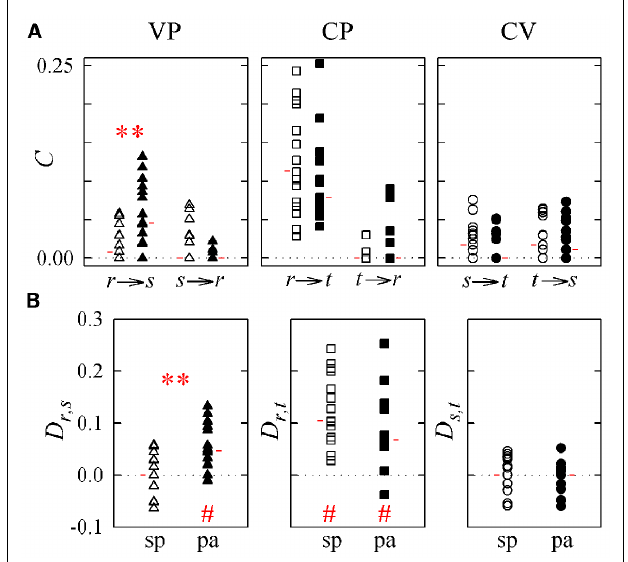
FIGURE 6 | Causal coupling index C (A) and directionality index D (B) computed for subjects during spontaneous breathing (sp, white symbols) and during paced breathing (pa, black symbols) in the study of vasculo-pulmonary (VP, triangles), cardio-pulmonary (CP, squares), and cardio-vascular (CV, circles) coupling ( r : respiration, s : systolic pressure; t : heart period). Horizontal red marks denote the median of